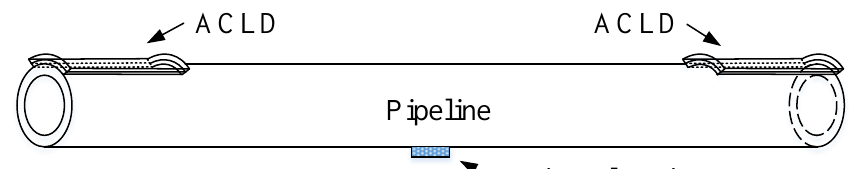
Figure 8. Schematic diagram of pipeline in case 2.